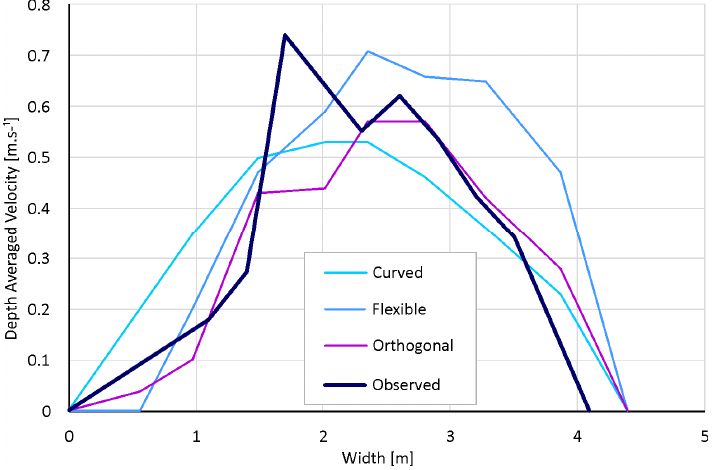
Figure 13. Flow velocity distribution at the characteristic cross-section C of the channel arch in comparison with the observed values under average hydrologic conditions. comparison with the observed values under average hydrologic